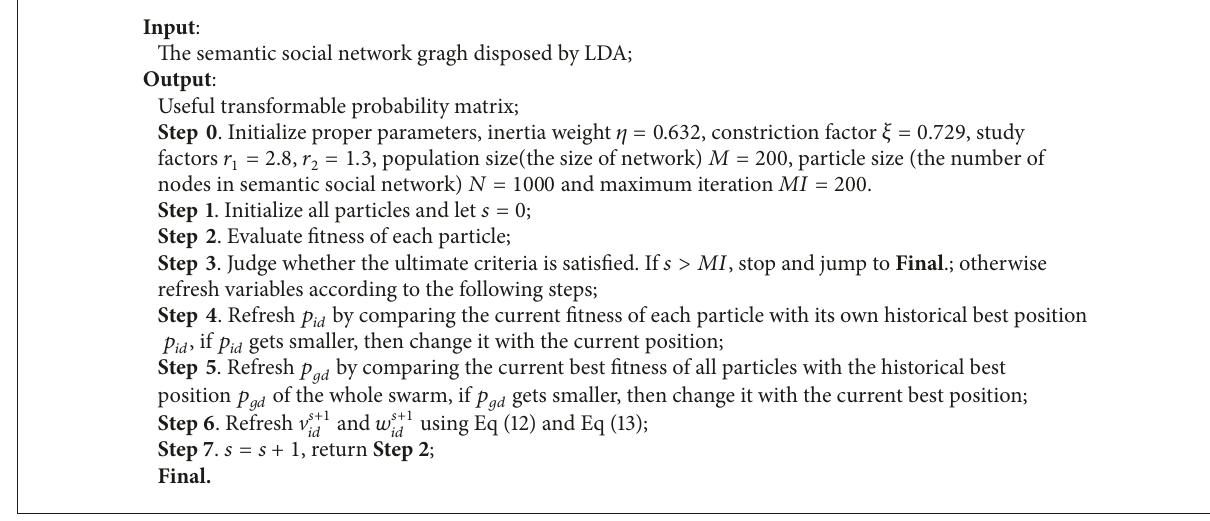
Algorithm 2: Optimization algorithm by